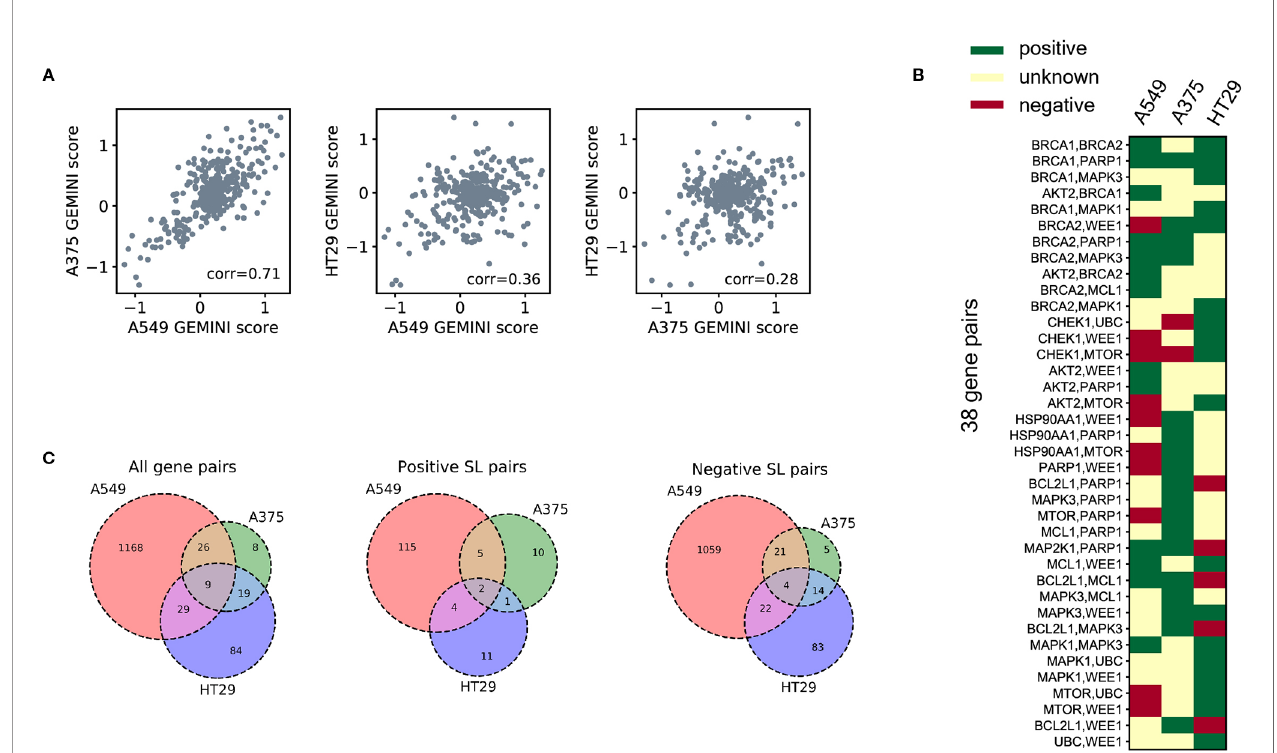
FIGURE 2 | SL datasets for three human cell lines. (A) Correlations of the GEMINI scores between three different cell lines for the same gene pairs measured in the Big Papi dataset. (B) The binary SL labels for the gene pairs in the Big Papi dataset. The 38 gene pairs measured in all the three cell lines and with at least one positive SL label are included in the fi gure. (C) The Venn diagrams of all labeled SL pairs, positive SL pairs, and negative SL pairs used in our dataset, which were constructed from the Big Papi dataset and other available CRISPR-Cas9 based experimental screens in the